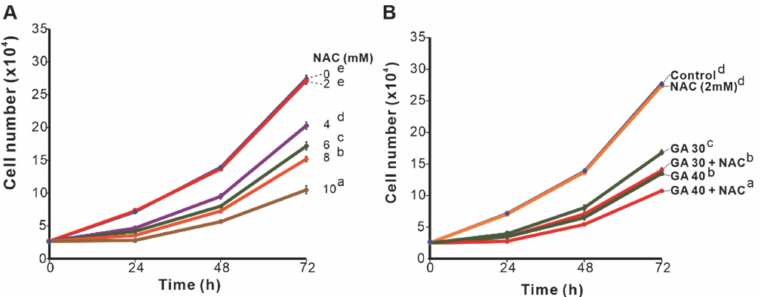
Figure 3. The effects of different concentrations of NAC on the proliferation of A549 cells. ( A ) NAC (2 mM) did not inhibit cell proliferation. However, the concentration of NAC was higher than 4 mM, which inhibited the proliferation of A549 cells in a dose-dependent manner. One-way ANOVA and the Scheff é test were used to analyze the effects of different concentrations of NAC on cell proliferation; F(5,12) = 506.427, p = 1.6 × 10 − 13 . ( B ) NAC (2 mM) alone did not inhibit cell proliferation, but enhanced GA-induced inhibition of proliferation in A549 cells; GA30 (30 µ g/mL), GA40 (40 µ g/mL). One-way ANOVA and the Scheff é test were used for analysis of cell proliferation; F(5,12) = 1644.47, p = 1.4 × 10 − 14 . The letters in the figure indicate the homogeneous subsets, and data sharing the same letter are not significantly different as determined by the Scheff é test ( p >